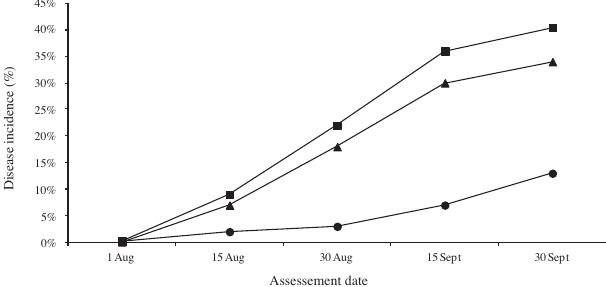
Figure 2. Disease incidence of Monilinia fructigena, incidence of Cydia pomonella damage and of mechanical injury on fruit in an organic apple orchard (Eperjeske, 2012; square = incidence of M. fructigena, triangle = incidence of Cydia pomonella, circle = incidence of mechanical